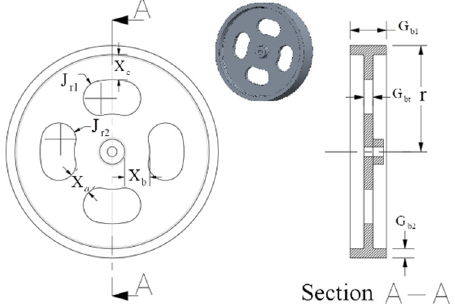
Figure 3. Schematic diagram of the flywheel shape parameters.